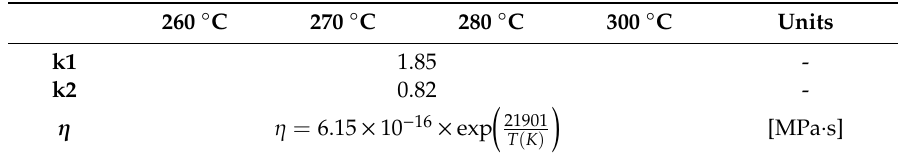
Table 3. Optimized parameters related to the intimate contact model for a 2 × 2 twill in carbon/PA 6-6 prepregs at different temperatures.